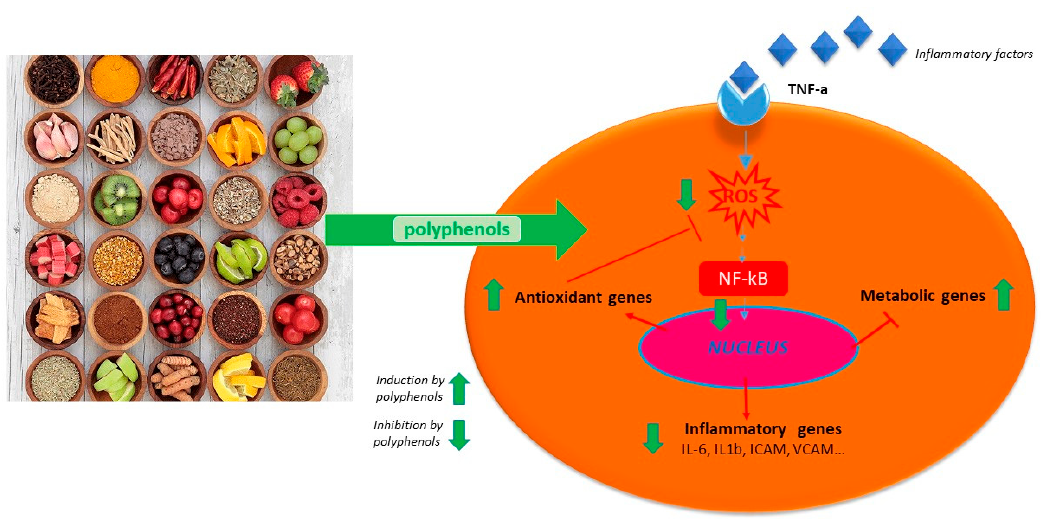
Figure 2. Schematic anti-inflammatory activities of natural polyphenols.